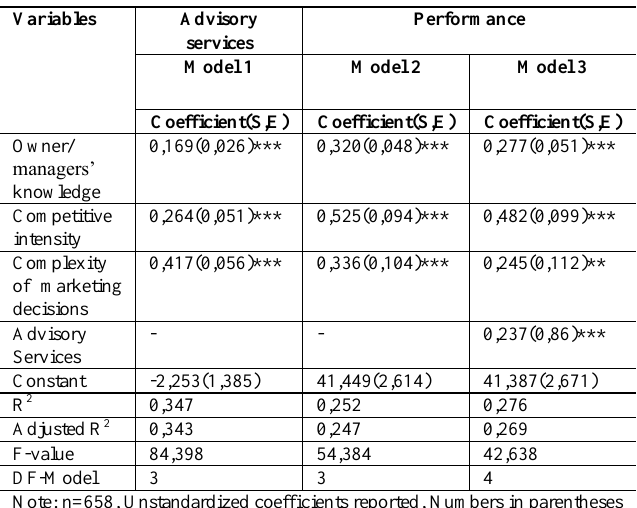
Table 4: Results of regression analyses for